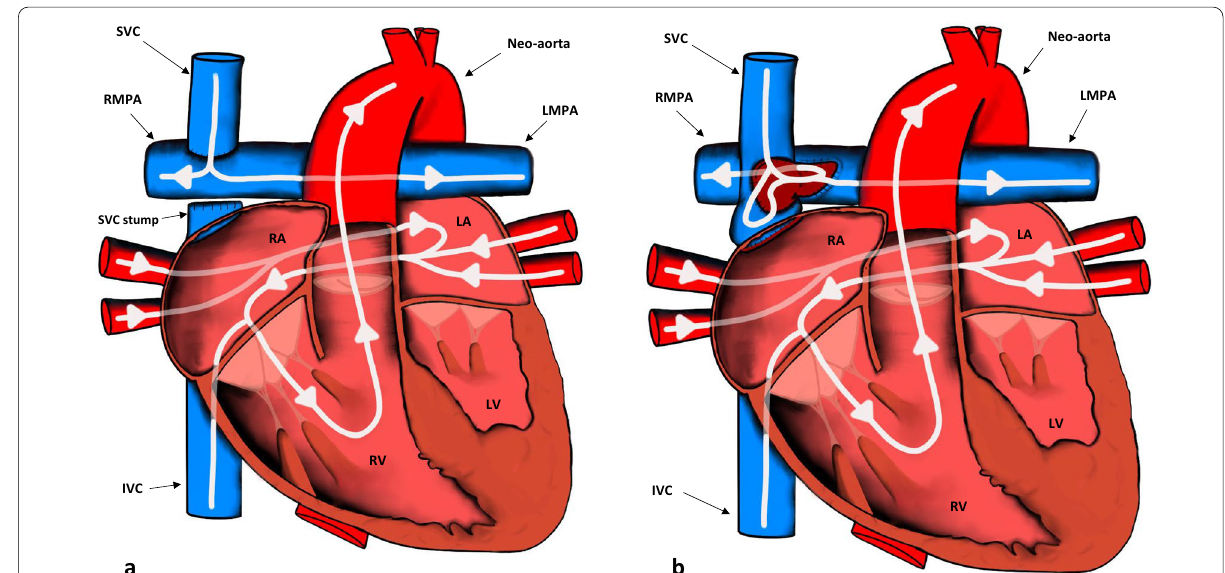
Fig. 6 a Appearances of the heart after the bi-directional Glenn procedure (Stage 2). Note that the SVC is closed off at or near its junction with the RA in contrast to the hemi-Fontan procedure. IVC: inferior vena cava; LA: left atrium; LV: left ventricle; LMPA: left main pulmonary artery; RMPA: right main pulmonary artery; RA: right atrium; RV: right ventricle; SVC: superior vena cava. b Appearances of the heart after the hemi-Fontan procedure (Stage 2). Note that the SVC remains in continuity with the RA in contrast to the bi-directional Glenn procedure. IVC: inferior vena cava; LA: left atrium; LV: left ventricle; LMPA: left main pulmonary artery; RMPA: right main pulmonary artery; RA: right atrium; RV: right ventricle; SVC: superior vena